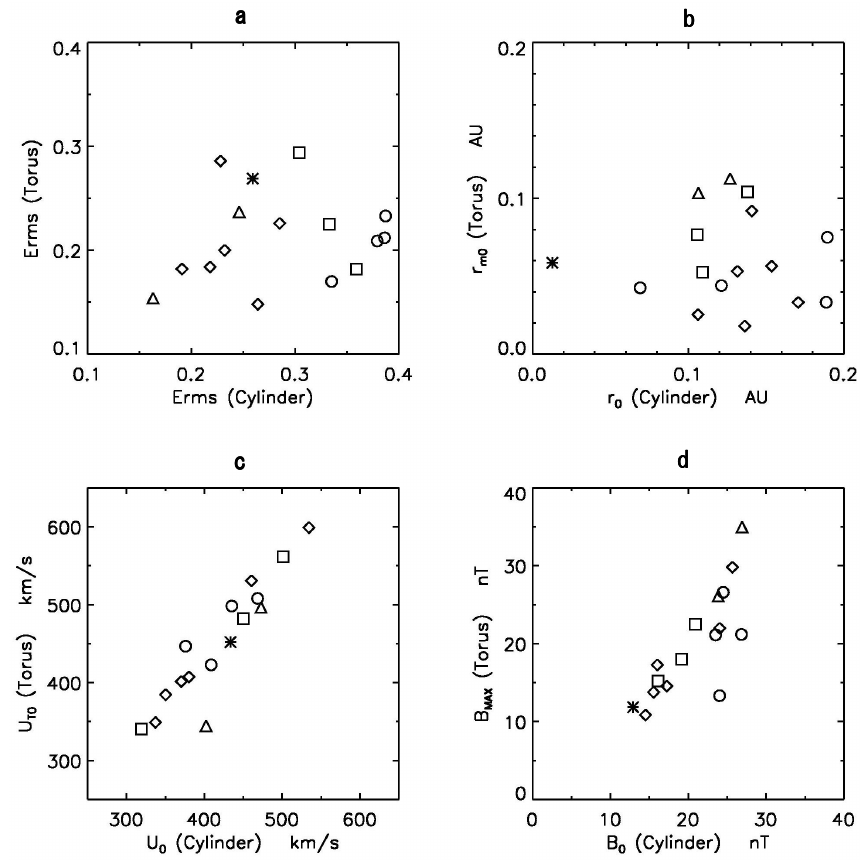
Fig. 13. Comparison of four fitted parameters obtained from the torus fitting and from the cylinder fitting: (a) the relative fitting error Erms ; (b) the radius of MC flux ropes; (c) the speed of the translational motion of the MC; and (d) the maximum field intensity within the MC. Parameters for MCs in the different groups are indicated with different marks (see